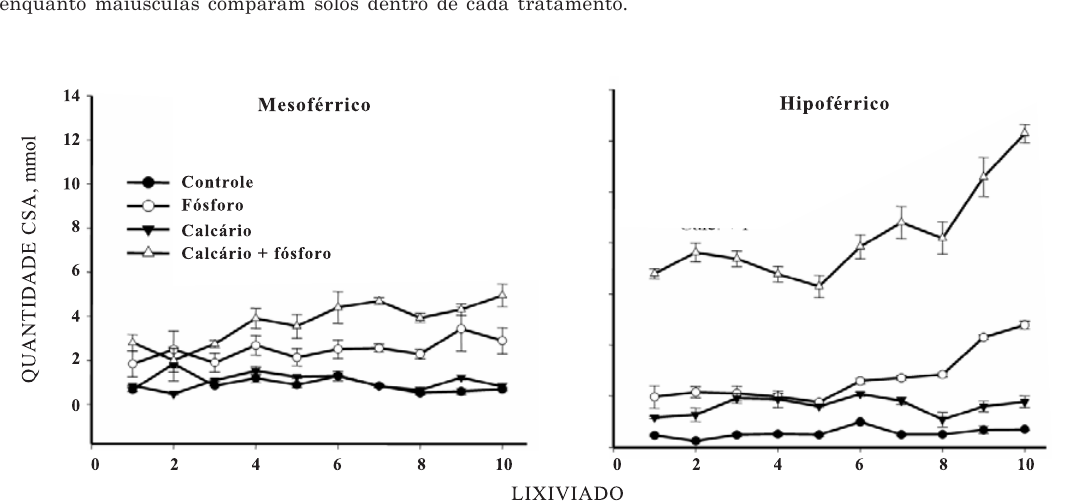
Figura 1. Distribuição das quantidades de C solúvel em água (CSA) em lixiviados de Latossolos Vermelhos (mesoférrico – LV1 e hipoférrico – LV2) tratados com calcário e, ou,